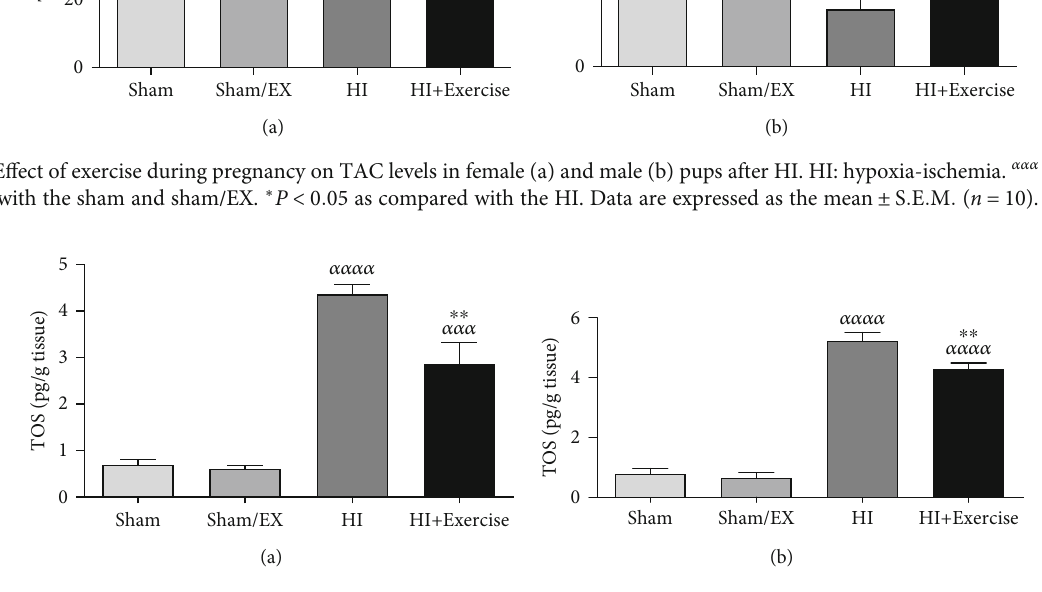
Figure 5: E ff ect of maternal exercise during pregnancy, on TOS levels in female (a) and male (b) pups after HI. HI: hypoxia-ischemia. ααα P < 0 : 001 , αααα P < 0 : 0001 as compared with the sham and sham/EX. ∗∗ P < 0 : 01 as compared with the HI. Data are expressed as the mean ± S : E : M : ( n = 10